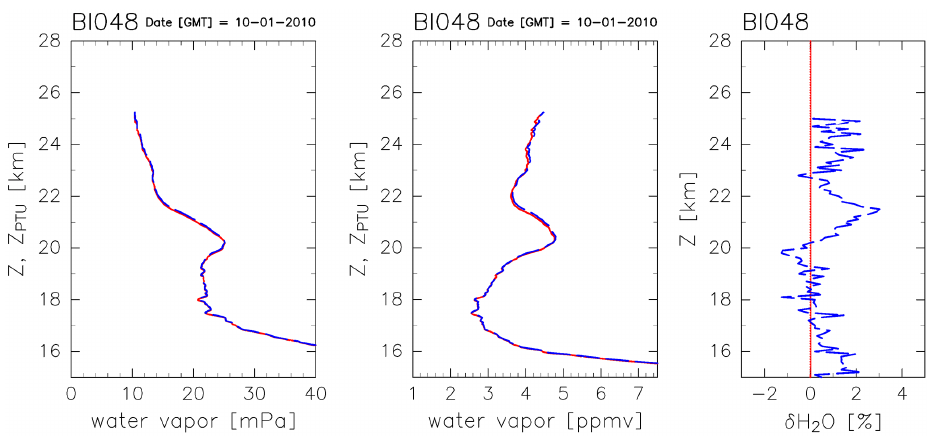
Figure 7. As for Fig. 3 but for (left) water vapor partial pressure ( p H 2 O (Z PTU ) ≡ p H 2 O PTU (Z) shown by the blue dashed line, and p H 2 O (Z) by the red line) and (center) water vapor mixing ratio ( χ H 2 O (Z PTU ) ≡ χ H 2 O PTU (Z) shown by the blue dashed line, and χ H 2 O (Z) by the red line). (Right) Difference in the ozone profiles for partial pressure and mixing ratio ( p H 2 O PTU (Z) minus p H 2 O (Z) or χ H 2 O PTU (Z) minus χ H 2 O (Z) ; blue dashed